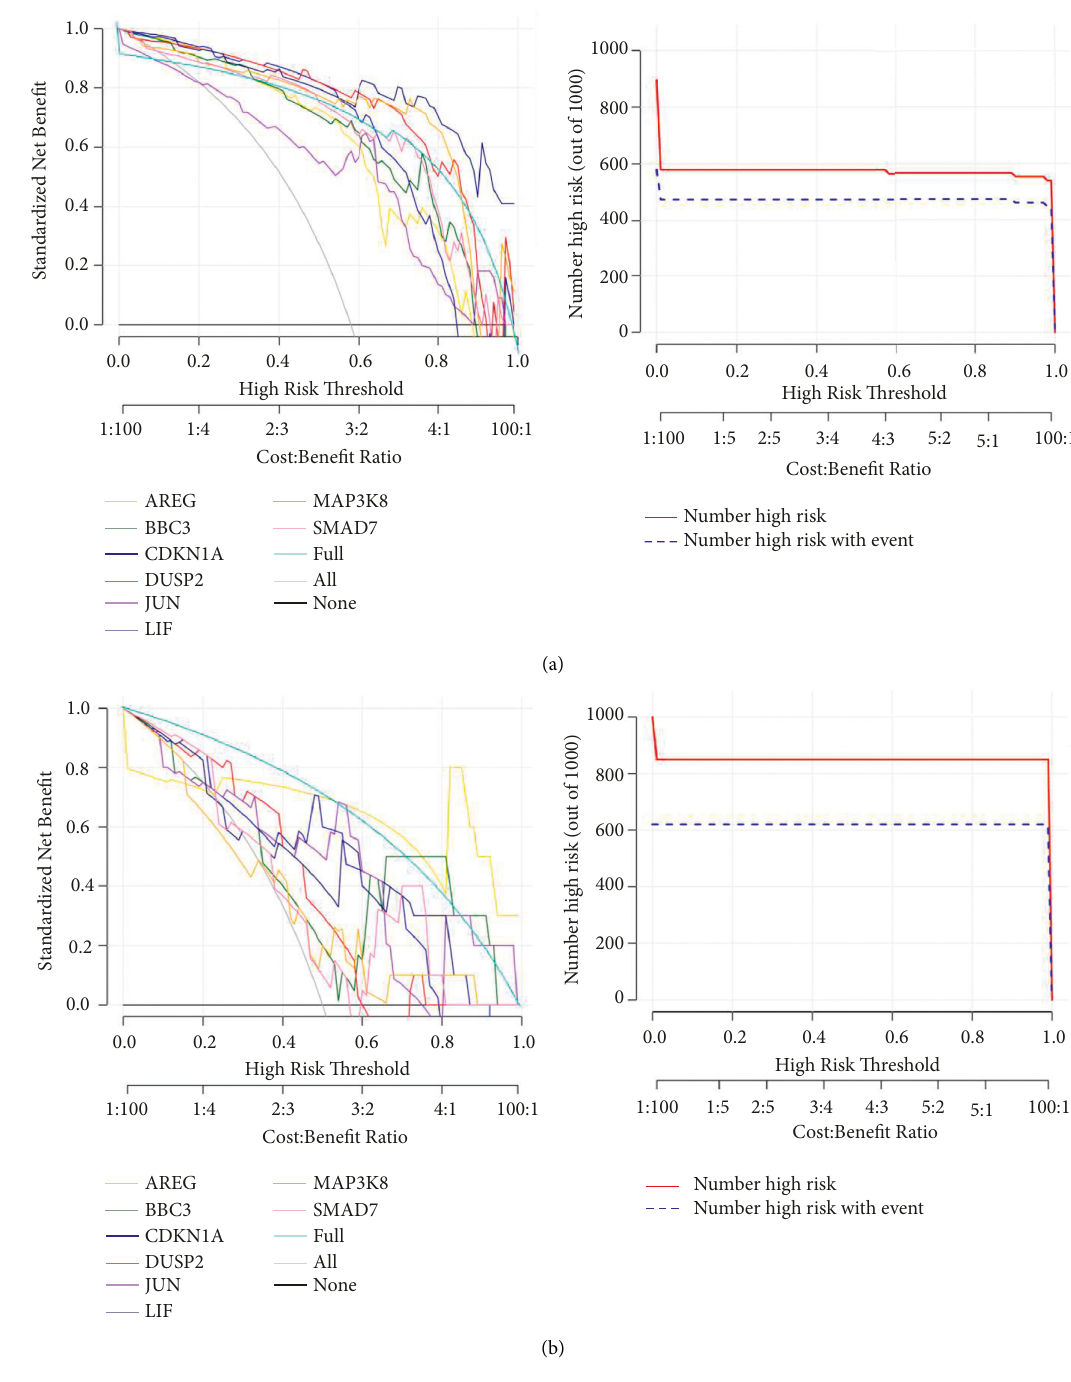
Figure 8: The decisive role in sample determination, and the results are shown in Figure